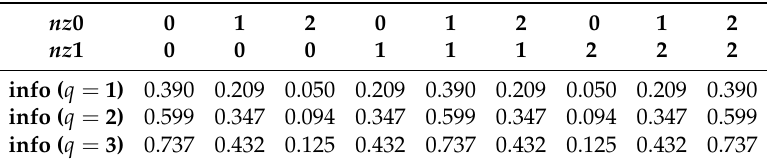
Table 1. Subset of table of mutual information (info) of q future sensor measurements, indexed by previous number of sensor measurements equal to zero ( nz 0) and number of sensor measurements equal to one ( nz 1). Note that in the actual algorithm, the lookup table is computed for values nz 0, nz 1 ≤ 20 and q ≤